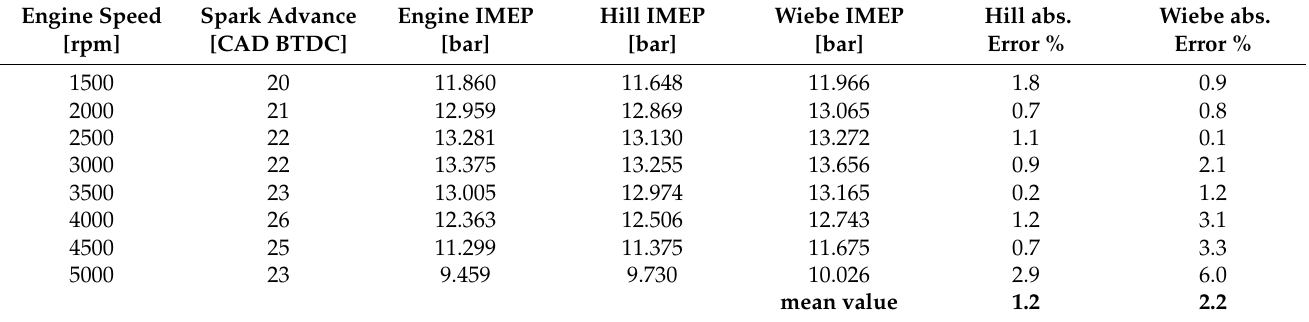
Table 14. Experimental and simulated IMEP with absolute prediction errors (80% NG; MAP = 1.4 bar).